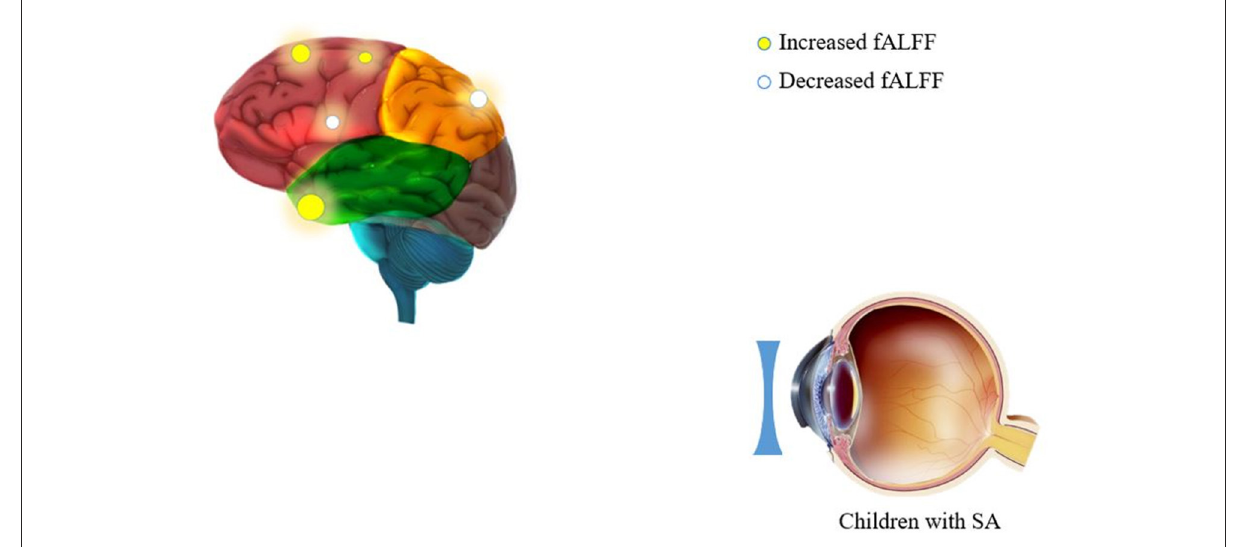
FIGURE5 Increase and decrease areas of flaff of children with SA.